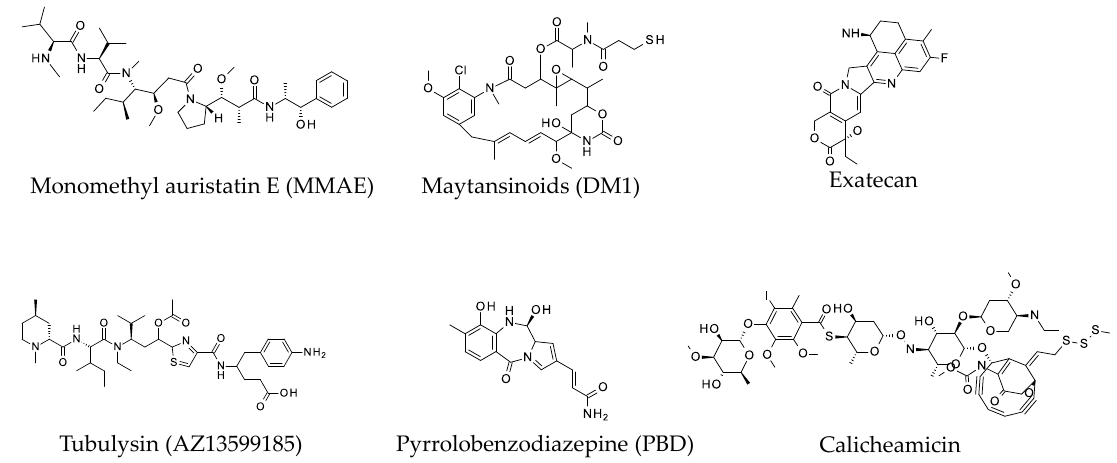
Figure 1. Structures of commonly used cytotoxic